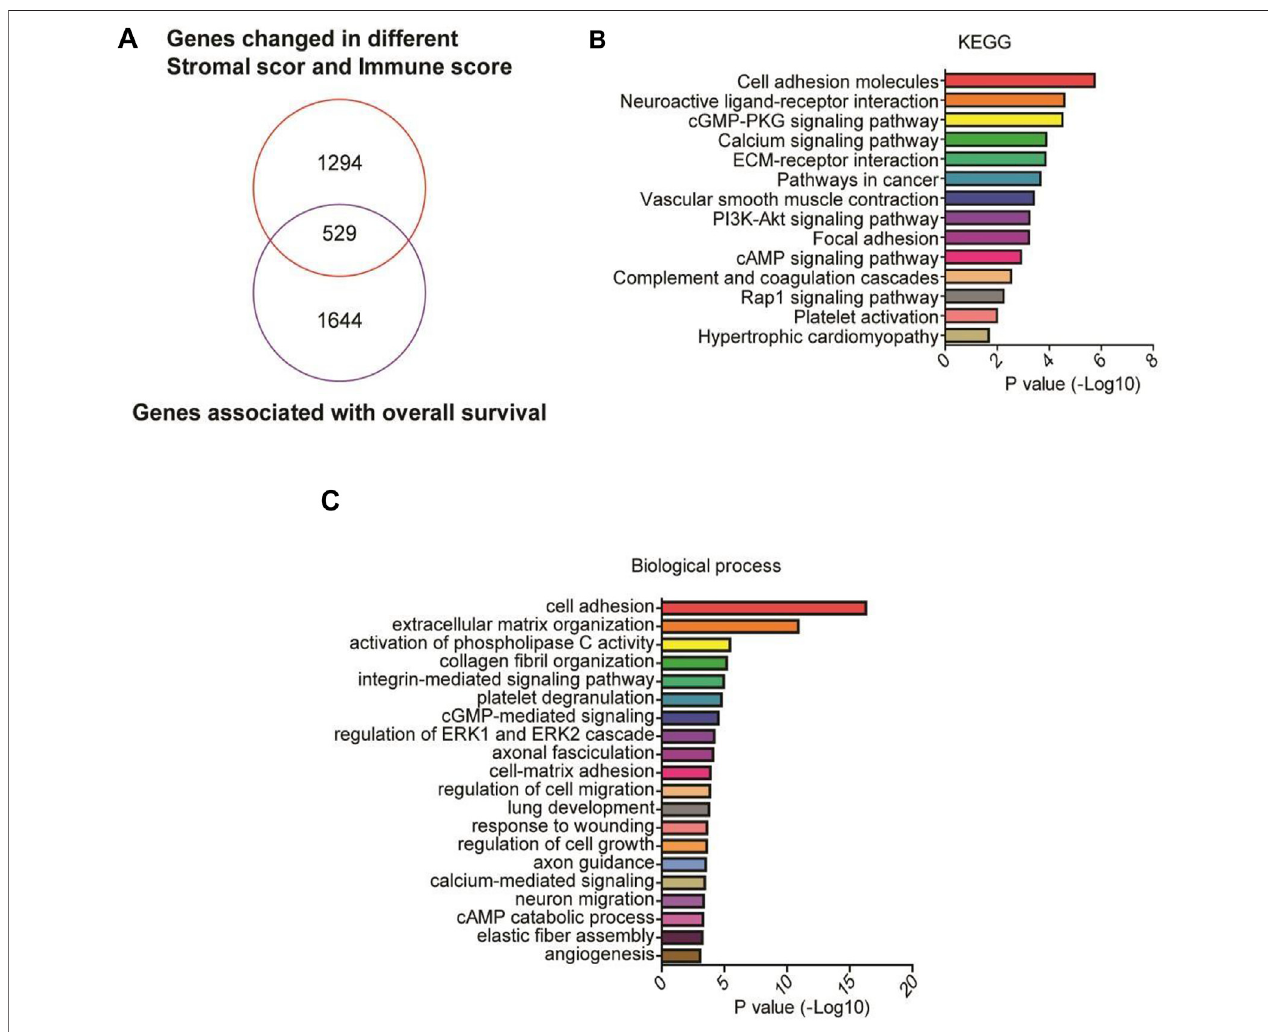
FIGURE 5 | GO and KEGG analyses of prognostic genes. (A) A Venn diagram depicts 529 DEGs in the intersection between 2,173 prognosis-related genes and 1823 upregulated high stromal/immune scores-related DEGs in the TCGA cohort, including the 9 genes that were negatively correlated with the overall survival of the patients. (B,C) Functional enrichment analysis of the 529 DEGs was performed using GO terms and KEGG pathways.